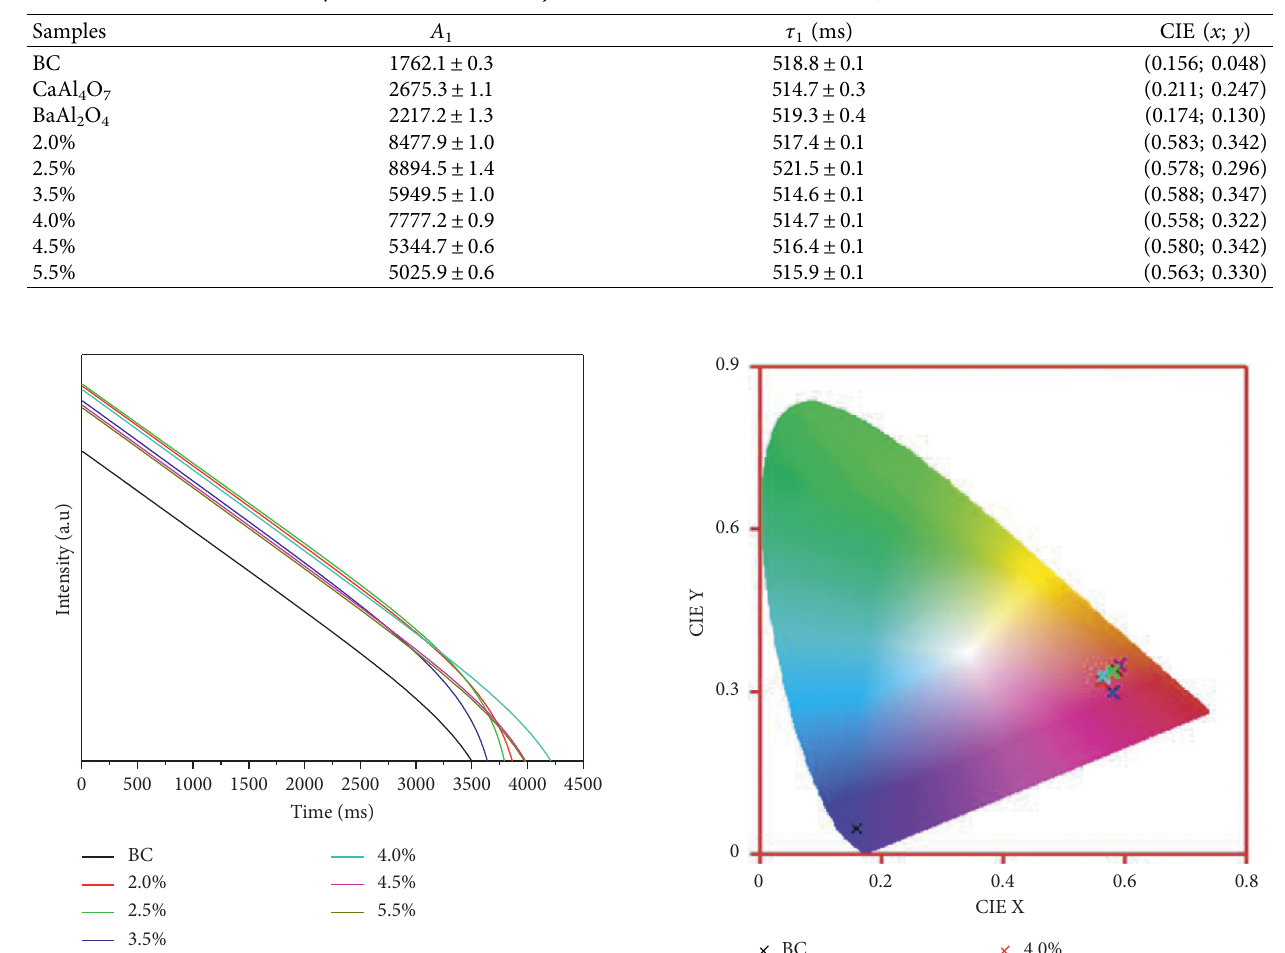
Figure 10: Logarithmic decay curves of BC: x % Eu 3+ (0 ≤ x ≤ 5.5).